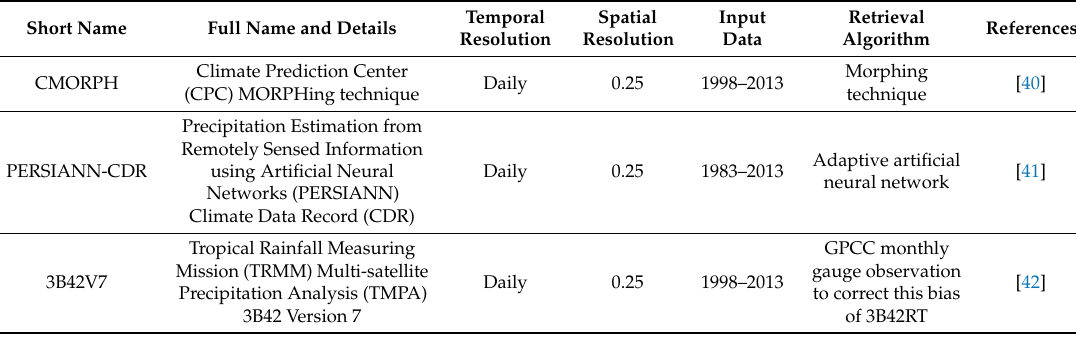
Table 1. General information of three satellite precipitation products in this